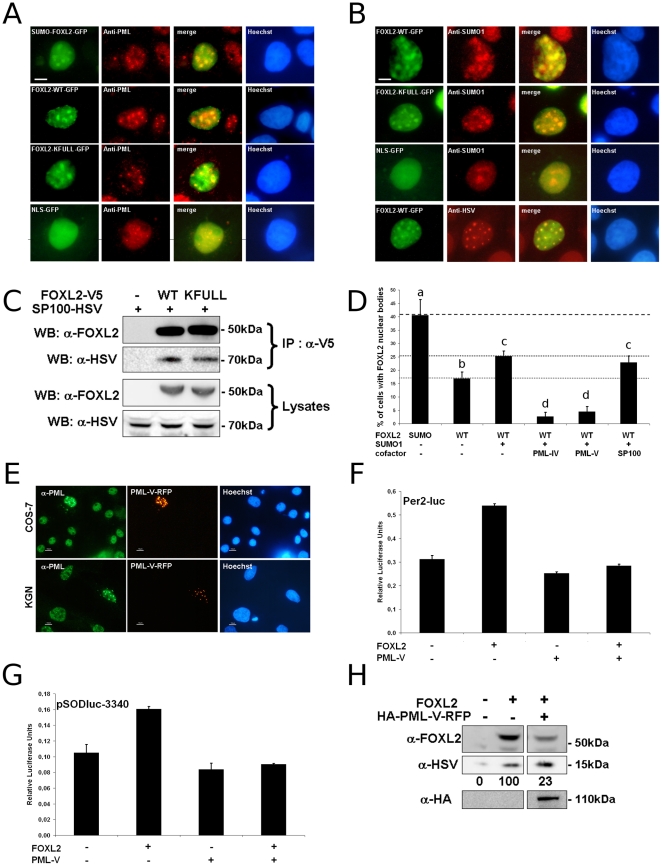
FOXL2 recruitment to PML Bodies enhances its transactivation ability.A and B) FOXL2 colocalization with PML, SUMO1 and SP100 in nuclear bodies. COS-7 cells overexpressing SUMO-FOXL2-GFP, FOXL2-WT-GFP, FOXL2-KFULL-GFP or NLS-GFP (as indicated, green color) were stained with an anti-PML antibody (panel A, red) or an anti-SUMO1 anti-body (panel B, first three lines, red) In the fourth line of panel B, COS-7 cells overexpressing FOXL2-WT-GFP and SP100A-HSV were stained with an anti-HSV antibody. Representative cells with FOXL2 enriched in nuclear bodies are shown. DNA was stained using Hoechst 33342 (in blue). Scale bar: 5 µm. Scale bar is valid for all micrographs. (C) Interaction between FOXL2 and SP100. SP100-HSV was expressed alone (lane 1) or co-expressed with V5-tagged FOXL2-WT (lane 2) or KFULL (lane 3). FOXL2 was precipitated using anti-V5-conjugated affinity resin for western blot analysis. Upper panel shows a 50 kDa band detected with anti-FOXL2 antibody. Second panel shows a 70 kDa band detected with an anti-HSV antibody. Third and fourth panels display a western blot analysis of the lysates, with anti-FOXL2 and anti-HSV antibodies, respectively. (D) Quantification of cells displaying subnuclear structures in COS-7 expressing SUMO-FOXL2-GFP or FOXL2-WT-GFP with or without overexpression of SUMO1, PML-IV-RFP, PML-V-RFP or SP100A-HSV. At least 300 GFP-positive cells were scanned per condition (in groups of 50 to estimate the standard deviations). Error bar: SEM. Letters a, b, c, d refer to statistical categories in a Student's t-test. Conditions with different letters are statistically different with p<0.05. (E) PML localisation in COS-7 or KGN cells overexpressing PML-V-RFP. Green: anti-PML directed against all isoforms of PML. Red: PML-V-RFP. Blue: DNA stained with Hoechst 33342. In non-transfected cells, PML is mostly nucleoplasmic with a few dots (1–5 in COS-7 cells, 5–20 in KGN cells) indicative of PML NBs. With PML-V-RFP expressed, PML NBs are much enlarged and the proportion of nucleoplasmic PML is decreased. Scale bar: 10 µm. Scale bar is valid for all micrographs. F and G) Luciferase assays in KGN cells transfected with Per2-luc and pSODluc-3340 (40 ng/well), respectively, with or without FOXL2 and PML-V-RFP overexpression (each 20 ng/well). Each value is representative of six biological replicates. Error bars represent SEM. Statistical significance in Student t-tests: n.s.: p>0.05, *: p<0.05, **: p<0.01, ***: p<0.001. H) Western blot of whole cell extracts of KGN cells transfected with or without FOXL2-V5 and PML-V-RFP (2 µg/well in a 6-well plate), using pcDNA3.1 as a mock vector. Lic- (expressing a fusion protein His-Tag∶S-Tag∶HSV-Tag∶His-Tag) was used as a transfection control (500 ng). First panel: FOXL2. Second panel: Lic- (anti-HSV). Third panel: PML-V (anti-HA). Below second panel is indicated the relative intensity of the FOXL2 band compared to the Lic- band. All experiments were repeated at least three times with consistent results.